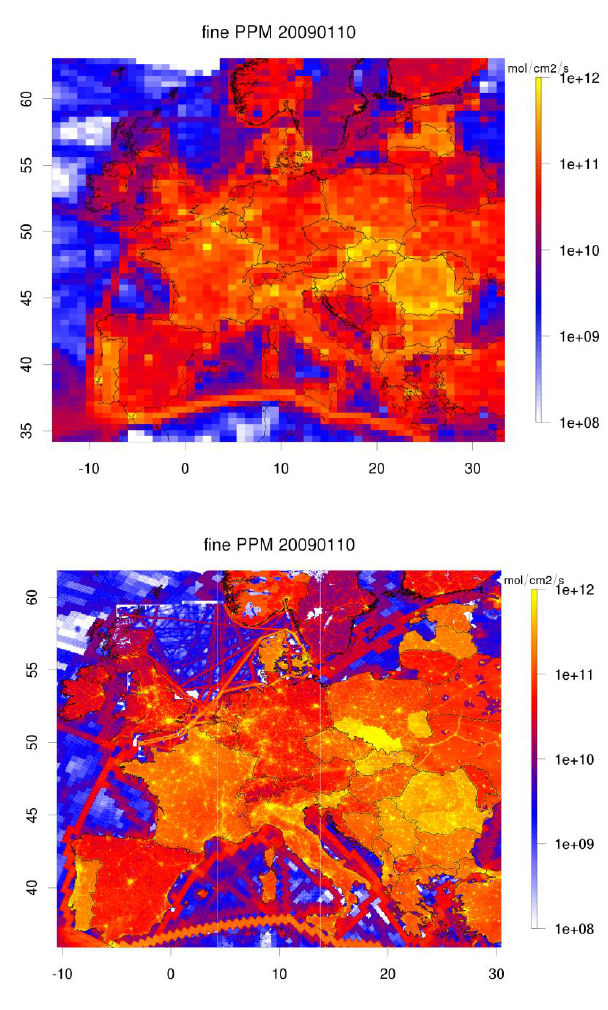
Figure 1: Map of emissions of fine primary particulate matter (PPM) emissions (in molecule/cm 2 /s) 2 over the day of January 10, 2009 in the 57km (top) and 2km (bottom) resolution domains. 3